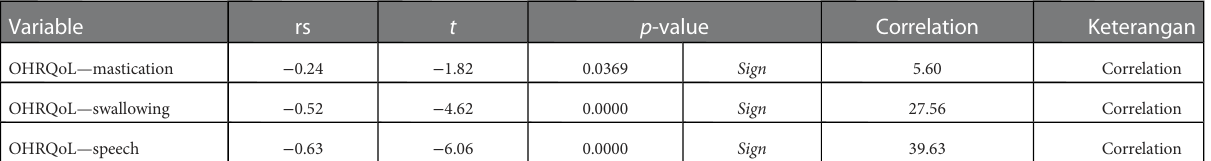
TABLE 5 Relationship between OHRQoL with each variable in the oral function of the stomatognathic system (chewing, swallowing, speaking) and Spearman ’ s rank correlation. Variable rs t p